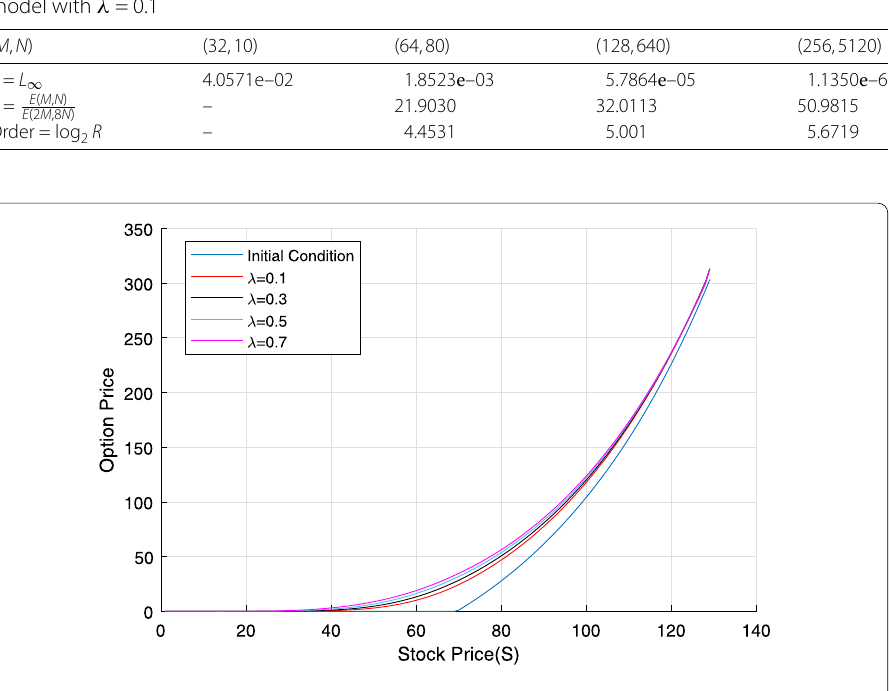
which are also used by Kwon and Lee [17]. In [17], an implicit method with three-time levels has been used. In Table 5, we present the numerical results obtained by using the CCD algorithm. The reference values evaluated by d’Halluin, Forsyth, and Vetzal [16] are with six digits after the decimal